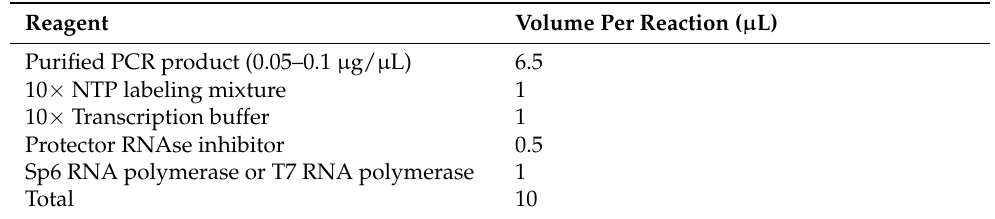
Table 10. Reaction mix for anti-sense probe preparation.